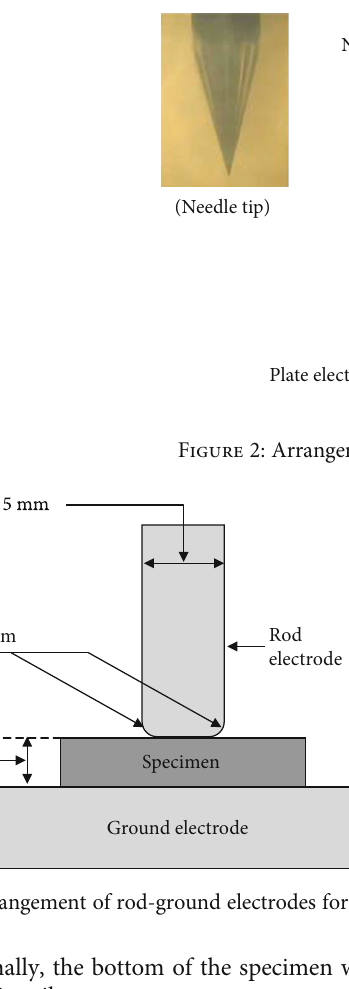
Figure 4: FT-IR spectra for (a) unmodi fi ed and (b) alkyl-modi fi ed